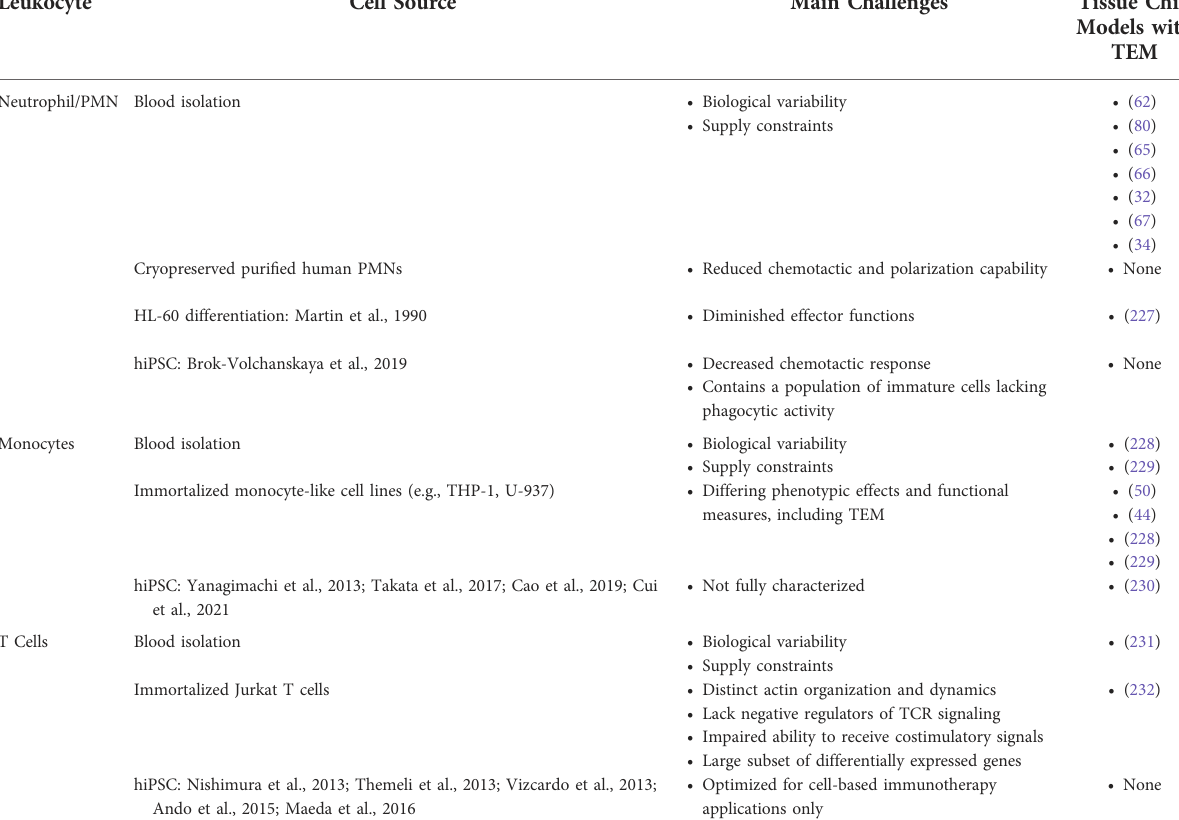
TABLE 4 Leukocyte sources for tissue models.